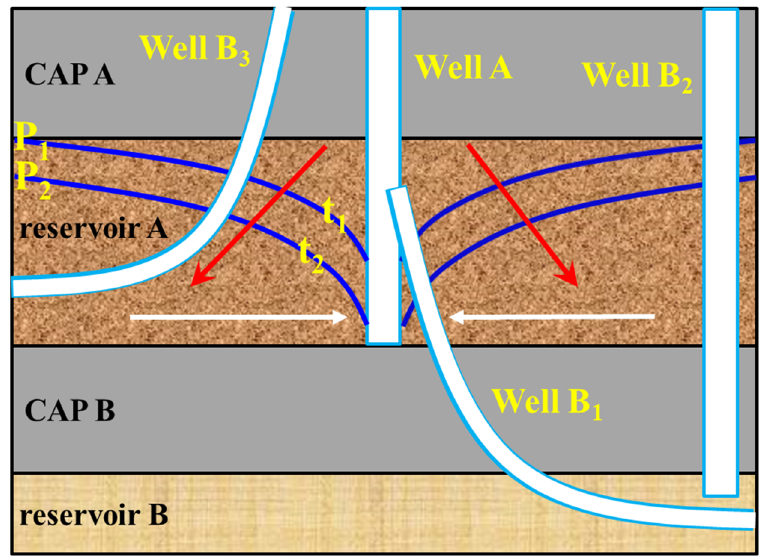
Figure 1. Newly drilled well in old reservoir schematic diagram.